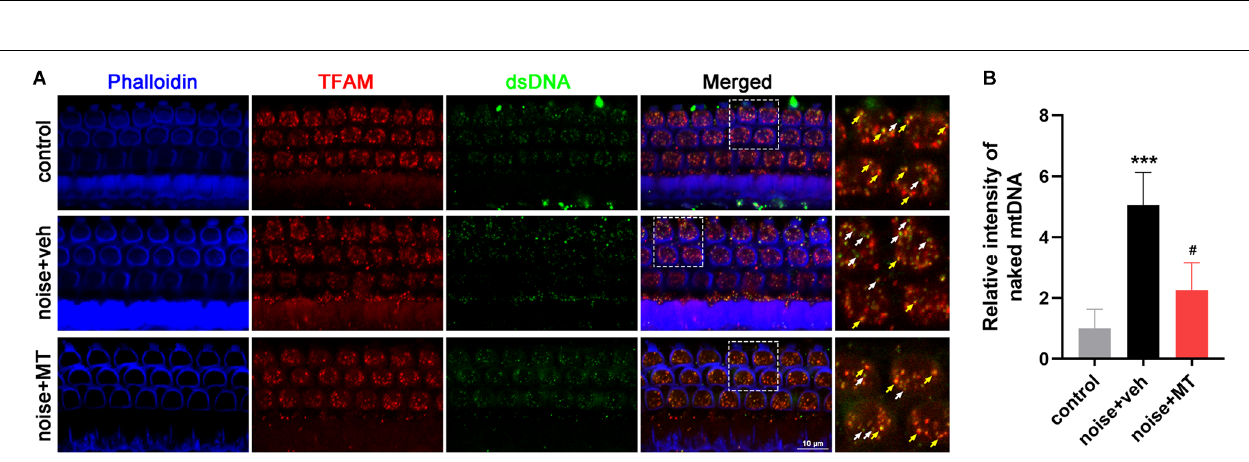
FIGURE 8 | MT treatment improved the disruption of TFAM-mtDNA interaction in the cochlea after the noise exposure. (A) Representative images of Phalloidin (blue), TFAM (red), and dsDNA (green) fluorescent staining in base turn area of the cochlear surface preparation 1 h after the noise exposure. Colocalized spots of TFAM and dsDNA were indicated in yellow arrows, while “orphan” dsDNA spots without colocalization of TFAM were indicated in the white arrows. (B) Quantification analysis of naked mtDNA in OHCs 1 h after the noise exposure. Data are presented as means ± SD, n = 4 for each group, *** p < 0.001 vs. control group, # p < 0.05 vs. vehicle-treated